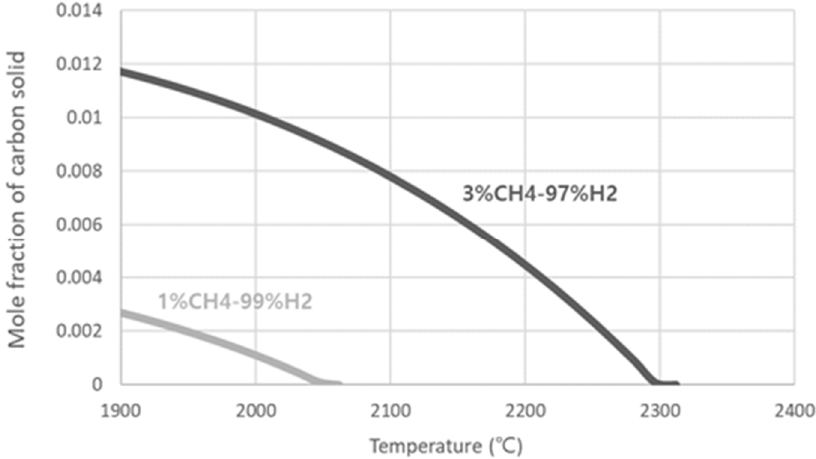
Figure 5. Thermodynamic calculations of the equilibrium mole fraction of carbon precipitation at methane concentrations of 1% CH 4 –99% H 2 and 3% CH 4 –97% H 2 by Thermo-Calc software using a Scientifica Group Thermodata Europe (SGTE) database [23].